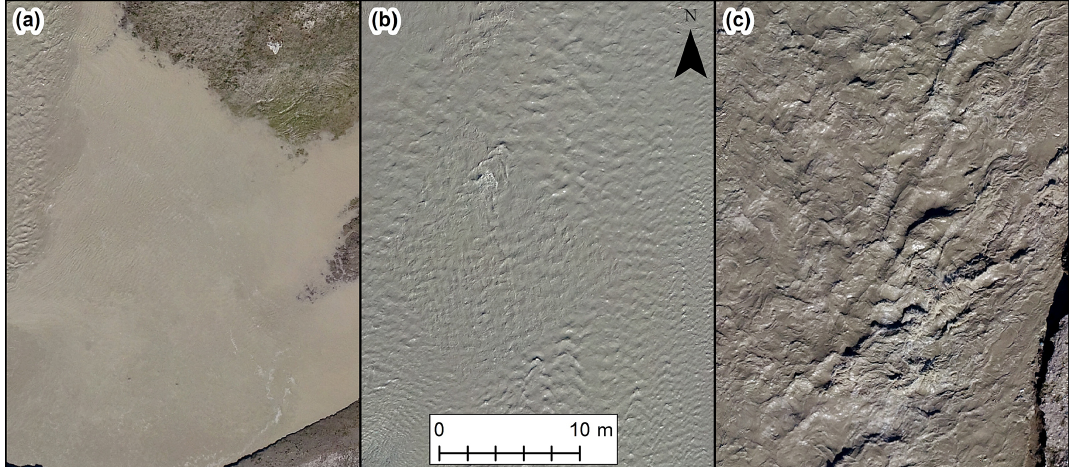
Figure 8. Different character of water surfaces: (a) stagnant and slow flowing water; (b) moderate flow rate; (c) rapid, turbulent water